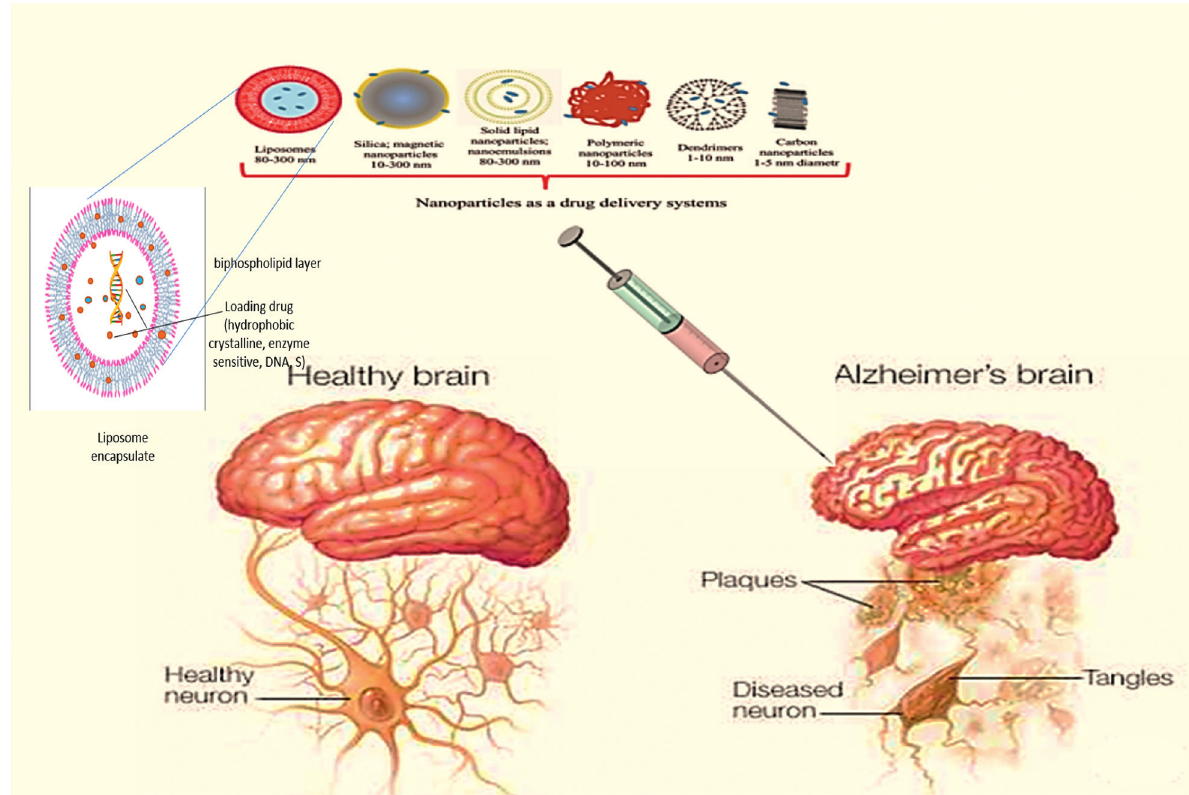
Figure 2: Diagrammatic ICV injection for different forms of drug-loaded